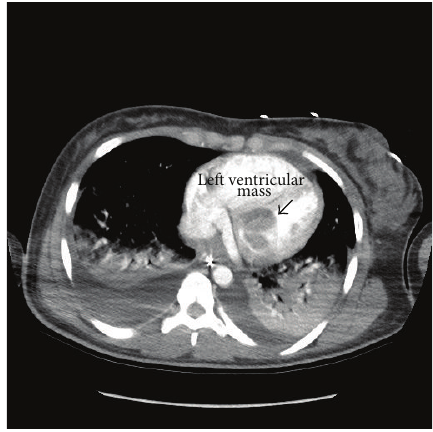
Figure 1: CT of the chest following intravenous contrast showing part of the mass extending into the left ventricular.